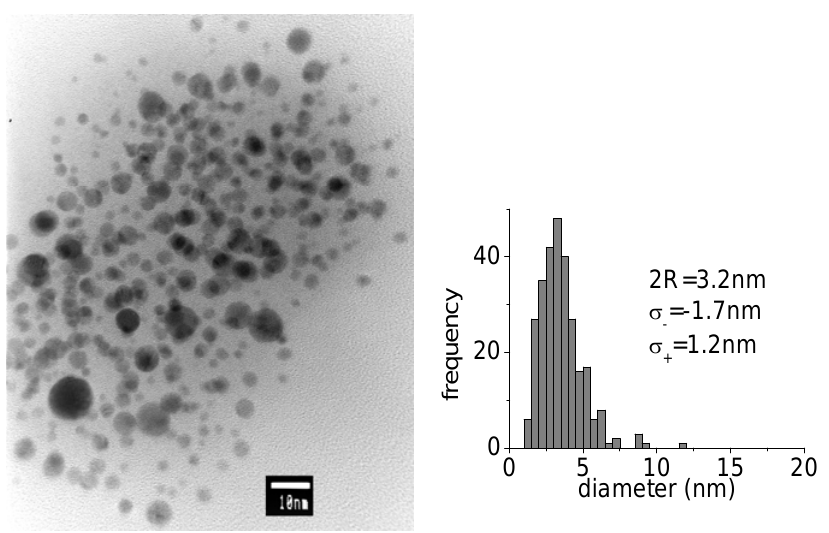
Figure 3. TEM image and statistical distribution of particle size for PAMAM G5-capped AuNPs produced with 1,064 nm, 15 mJ.